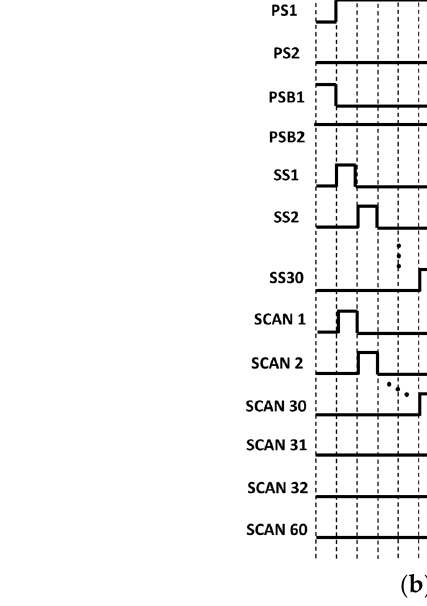
Figure 2. Block diagram of the proposed scan driver ( a ) and its timing chart ( b ).